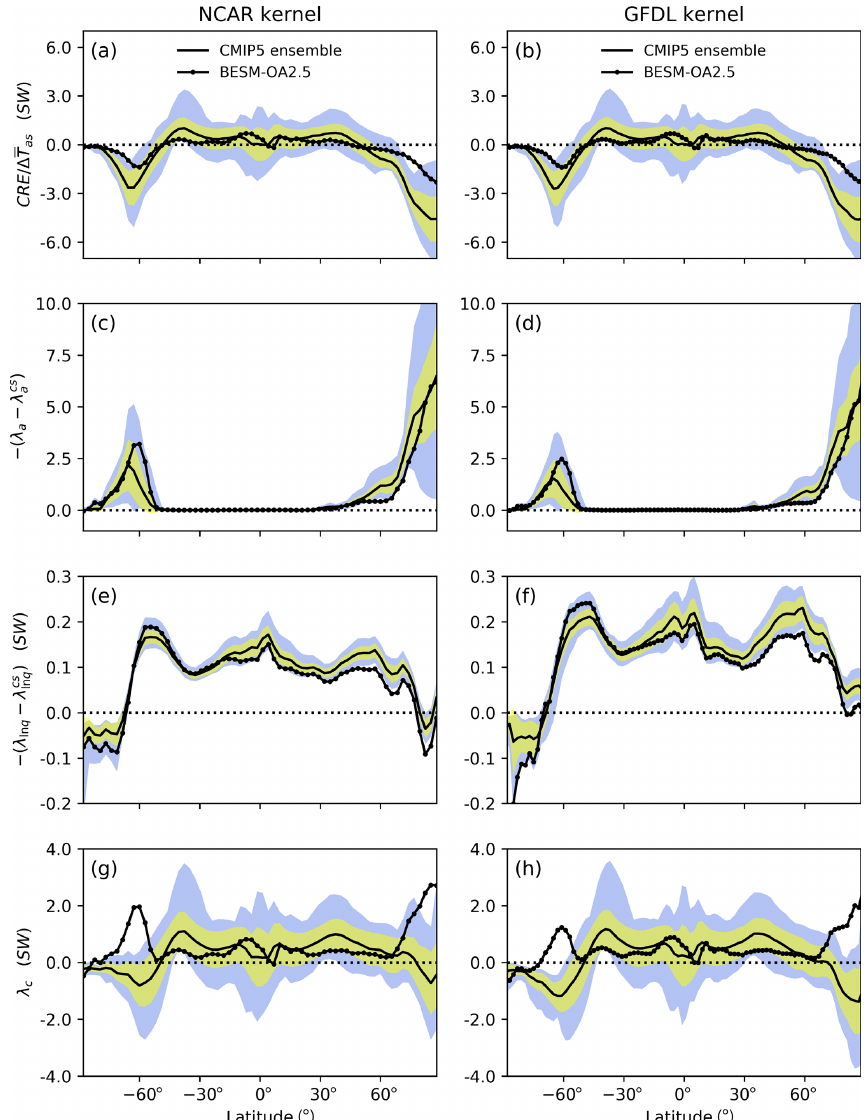
Figure 6. Shortwave cloud radiative effect (a, b) , the albedo (c, d) and shortwave water vapor (e, f) feedback cloud maskings, and shortwave cloud feedback (g, h) for the CMIP5 multi-model ensemble mean (solid line) and BESM-OA2.5 (solid line with dots). Inter-model standard deviations for each latitude are in yellow. In blue are the feedback limits based on the maximum and minimum values for each latitude among the models, excluding BESM-OA2.5 (physical units of these feedbacks: Wm − 2 K − 1